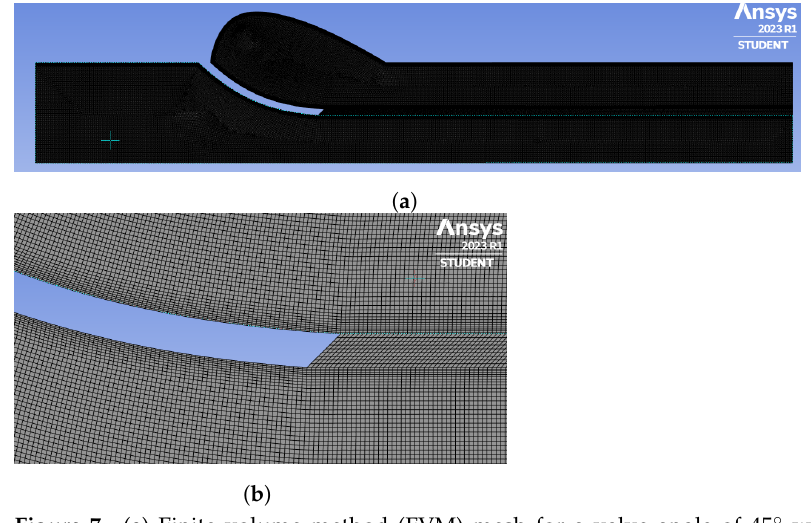
Figure 7. ( a ) Finite volume method (FVM) mesh for a valve angle of 45 ◦ with a cell count of approximately 135,000 ( b ) close-up view of the mesh near the valve leaflet tip.